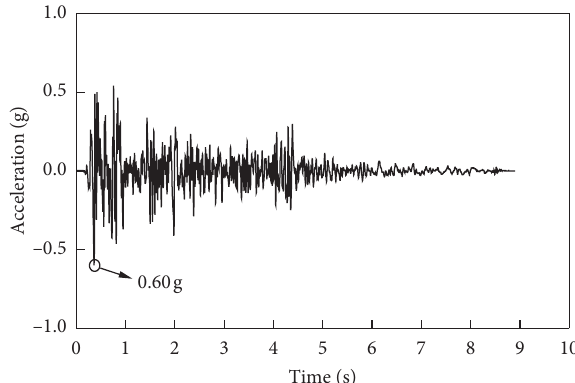
Figure 6: Acceleration-time-history of testing earthquake wave.